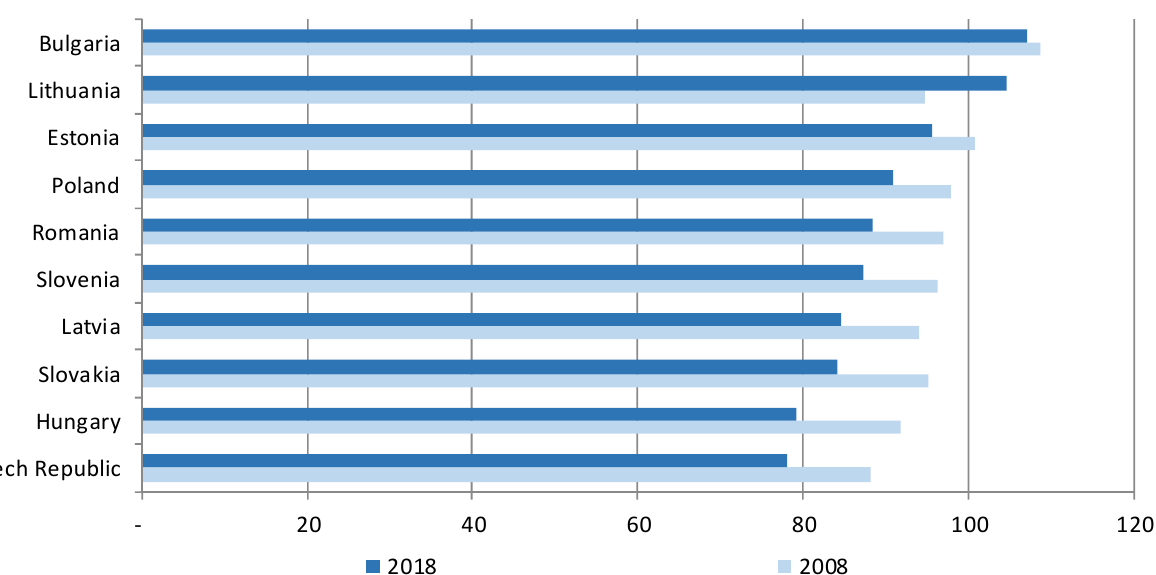
Figure 7. GGE from energy consumption (100 = emissions in 2000) in CEE countries in 2008 and 2018. In other CEE countries, a positive, downward trend in GGE was recorded. It was significant, exceeding 10 percentage points, in the Czech Republic, Slovakia, and